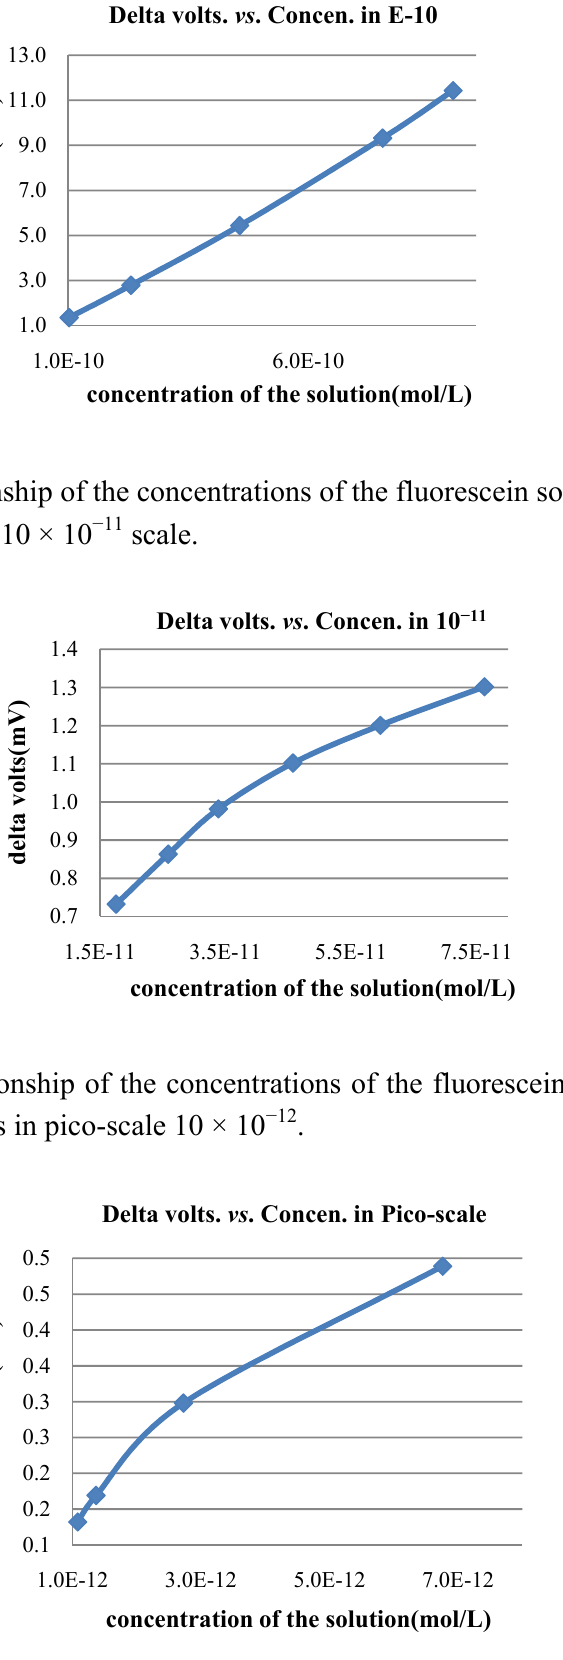
Figure 8. The relationship of the concentrations of the fluorescein solution samples and the voltage differences in 10 × 10 − 10 scale.